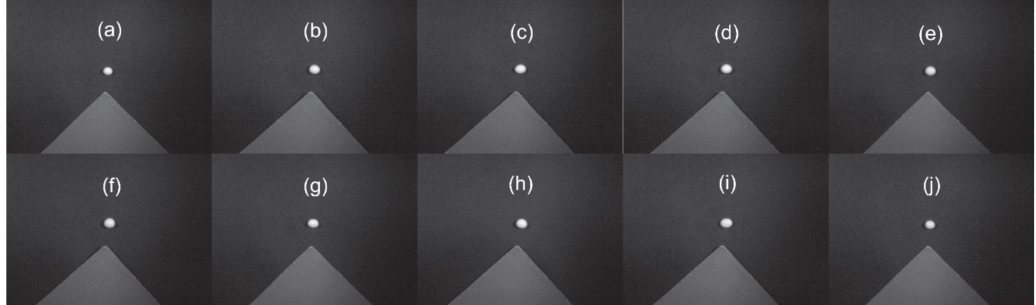
Figure 6. Hyperspectral images of the front of each soybean variety. ( a ) Nannong 1606; ( b ) Shangdou 161; ( c ) Shangdou 1201; ( d ) Shangdou 1310; ( e ) Yudou 18; ( f ) Yudou 22; ( g ) Yudou 25; ( h ) Zheng 196; ( i ) Zheng 3074; and ( j ) Zheng 9525.